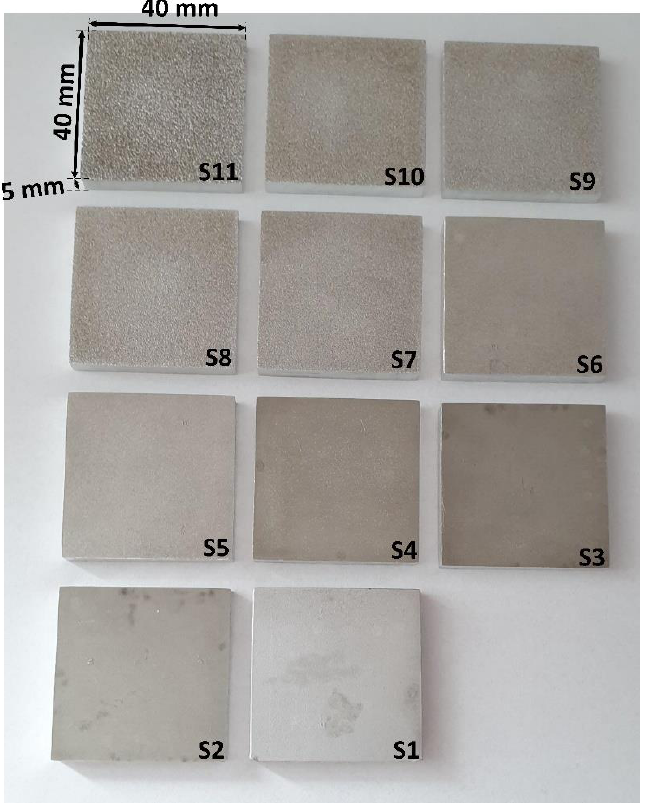
Figure 1. View of samples prepared for surface topography analysis after EDM process.